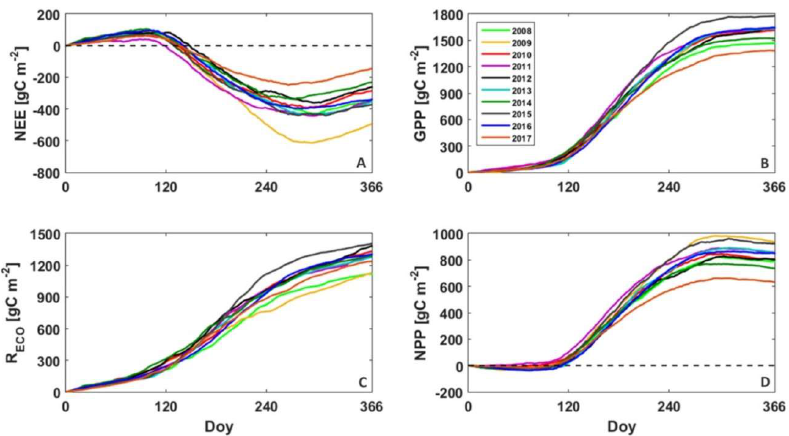
Figure A4. 3D scatter plot of NEE versus the principal component PC3 and PC4 .